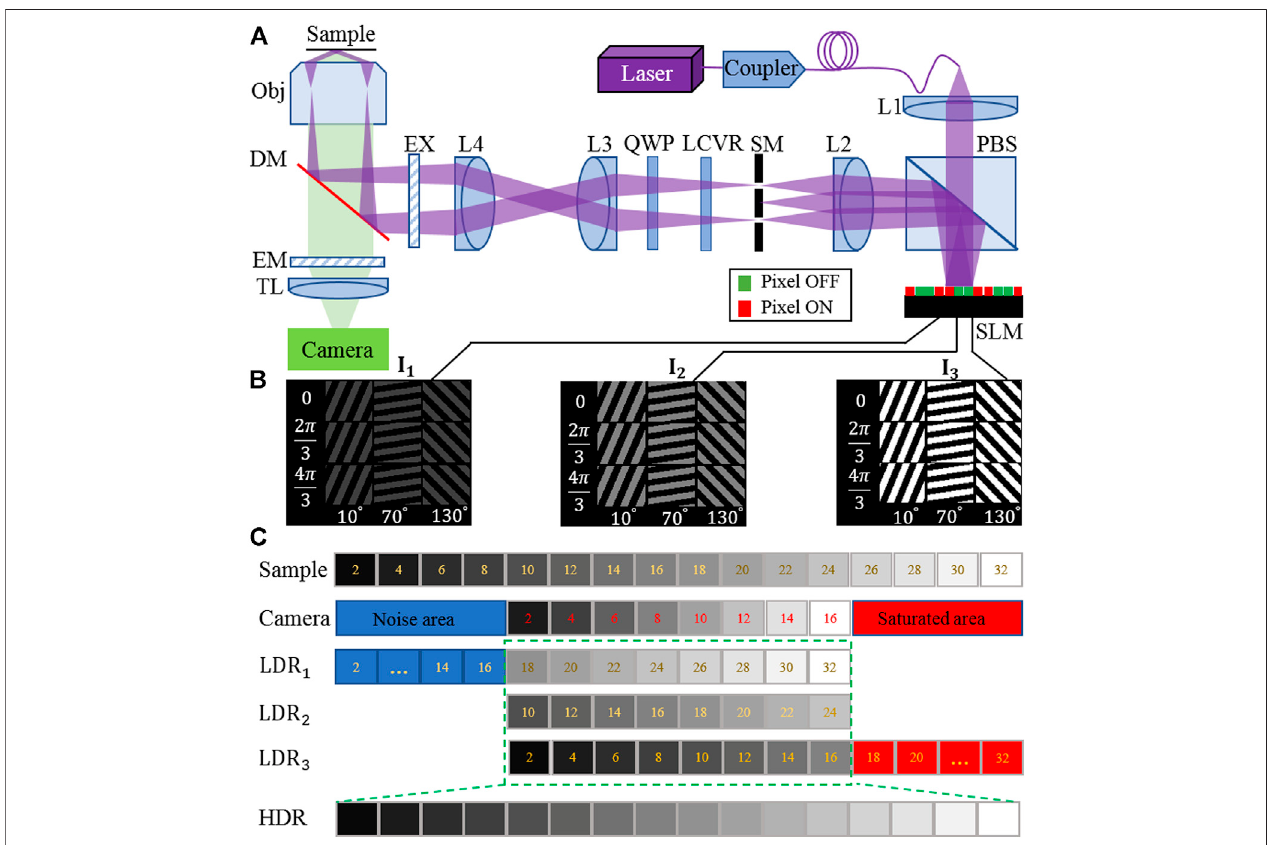
FIGURE 1 | (A) Layout ofthe high dynamic range structured illumination microscopy (HDR-SIM) setup. PBS, polarization beam splitter; L1 – L4, lenses; SM, spatial mask; LCVR, liquid crystal variable retarders; QWP, quarter-wave plate; EX, excitation fi lter; DM, dichroic mirror; EM, emission fi lter; TL, tube lens; SLM, spatial light modulator. (B) Three sets of illumination patterns with different orientation angles, phase, and intensity were loaded on the SLM, corresponding to 0.25, 0.5, and 1 time themaximumincidentlightintensity. (C) PrincipleofthefusingprocessofrawimagesintoHDRrawdata.Withthecamera ’ slimiteddynamicrange,onlyaportionof the sample information can be used effectively for each illumination set (green